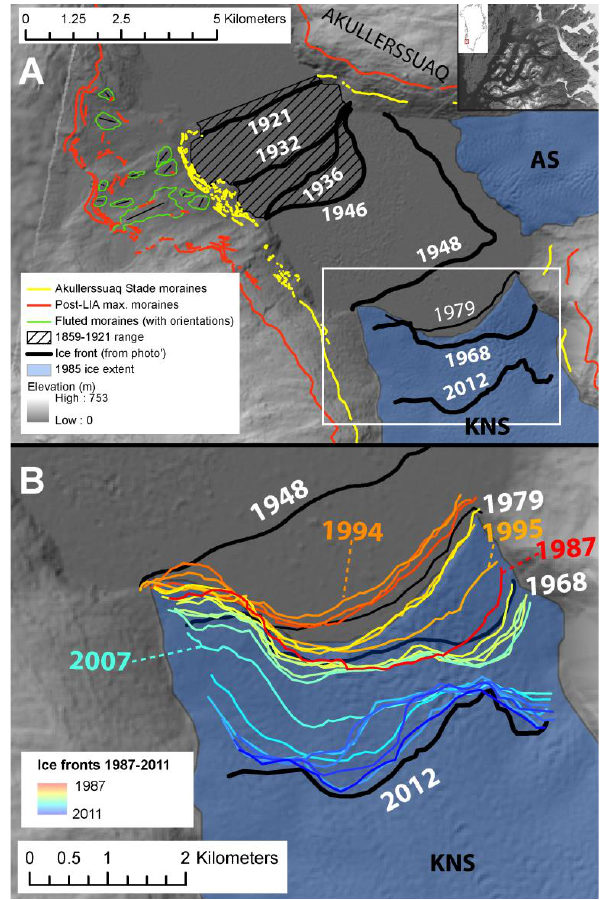
Figure 1. Diagrams showing the site location (inset), terminus positions, and geomorphology plotted on a hillshaded mosaic of a stereophotogrammetrically derived digital elevation model (DEM) from images acquired in 1985, and ASTER GDEM (Hvidegaard et al., 2012). (a) Termini and geomorphology for 1859–2012, with ASM limits delineated in yellow, and (b) a detailed view of termini for the period 1948–2012, with specific years labelled for reference.